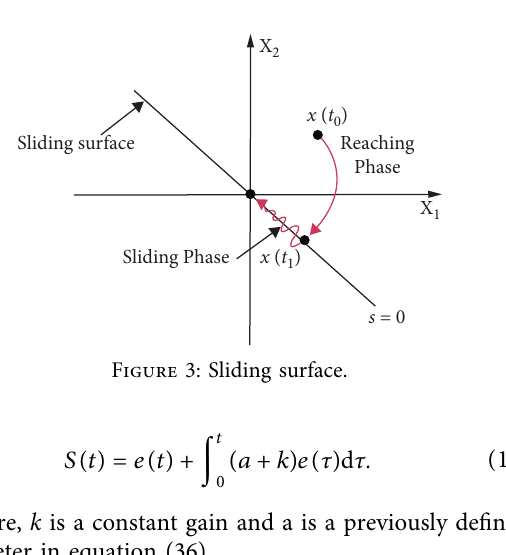
Figure 3: Sliding